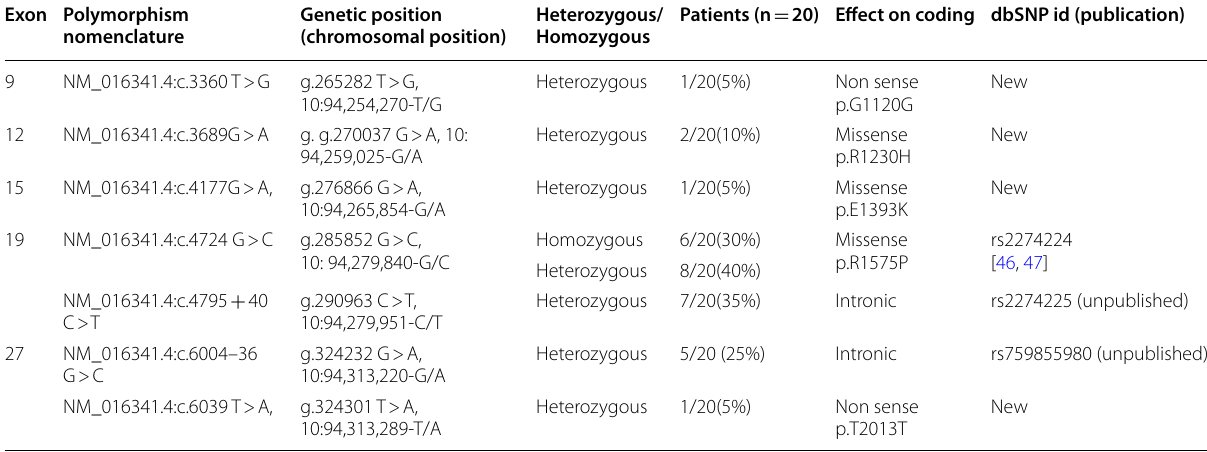
Table 4 A summary of detected SNPs identified using BLAST alignment, and their nomenclature according to the HGVS